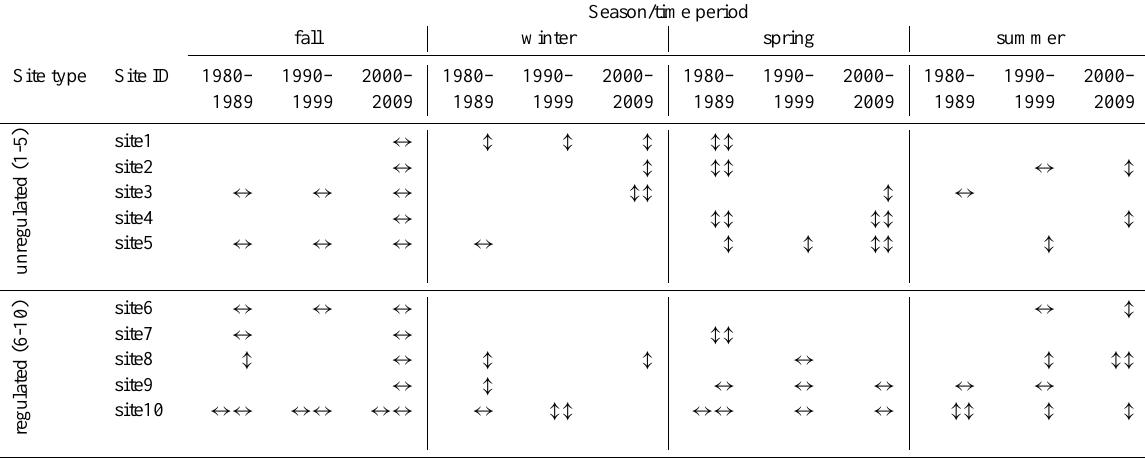
Table 3. Types of kurtosis of probability distributions of daily minimum stream temperature by season and decade at unregulated and regulated sites. ↔↔ : platykurtic; ↔ : moderately platykurtic; (cid:108)(cid:108) : leptokurtic, and (cid:108) : moderately leptokurtic. Mesokurtic distributions are not shown (see Tables S4–S6 for more